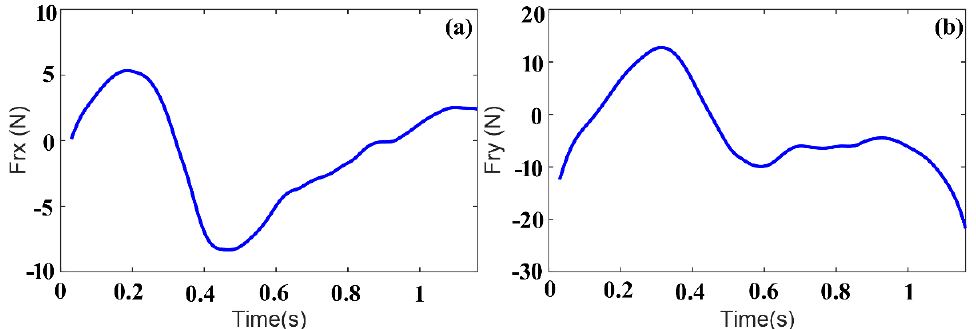
Figure 6. The constrained joint forces in the ( a ) X and ( b ) Y